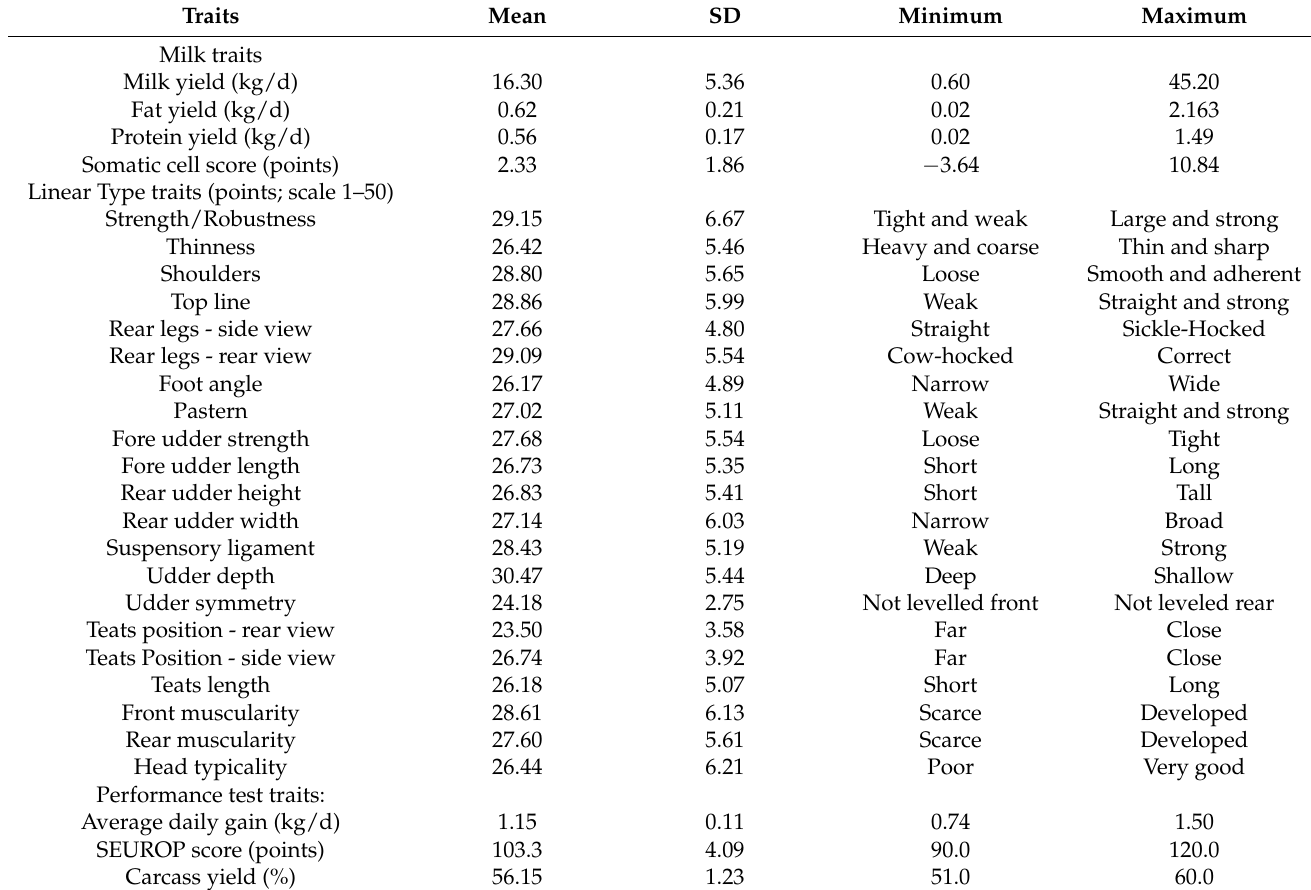
Table 1. Descriptive statistics of analyzed